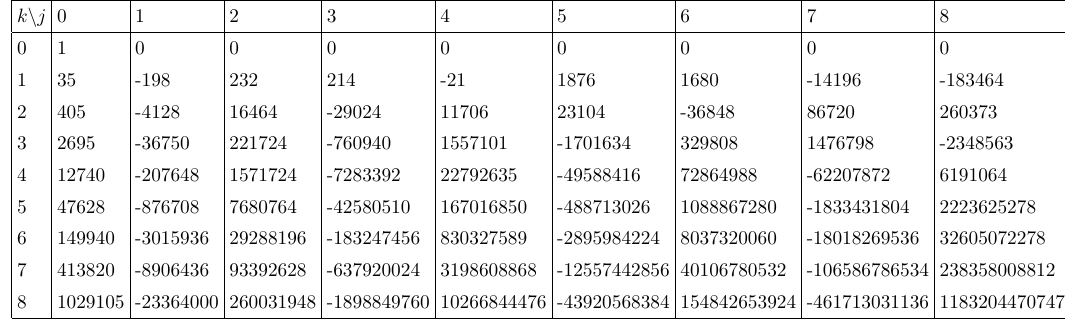
Table 30. Table of b jk coe(cid:14)cients for h SU(6)